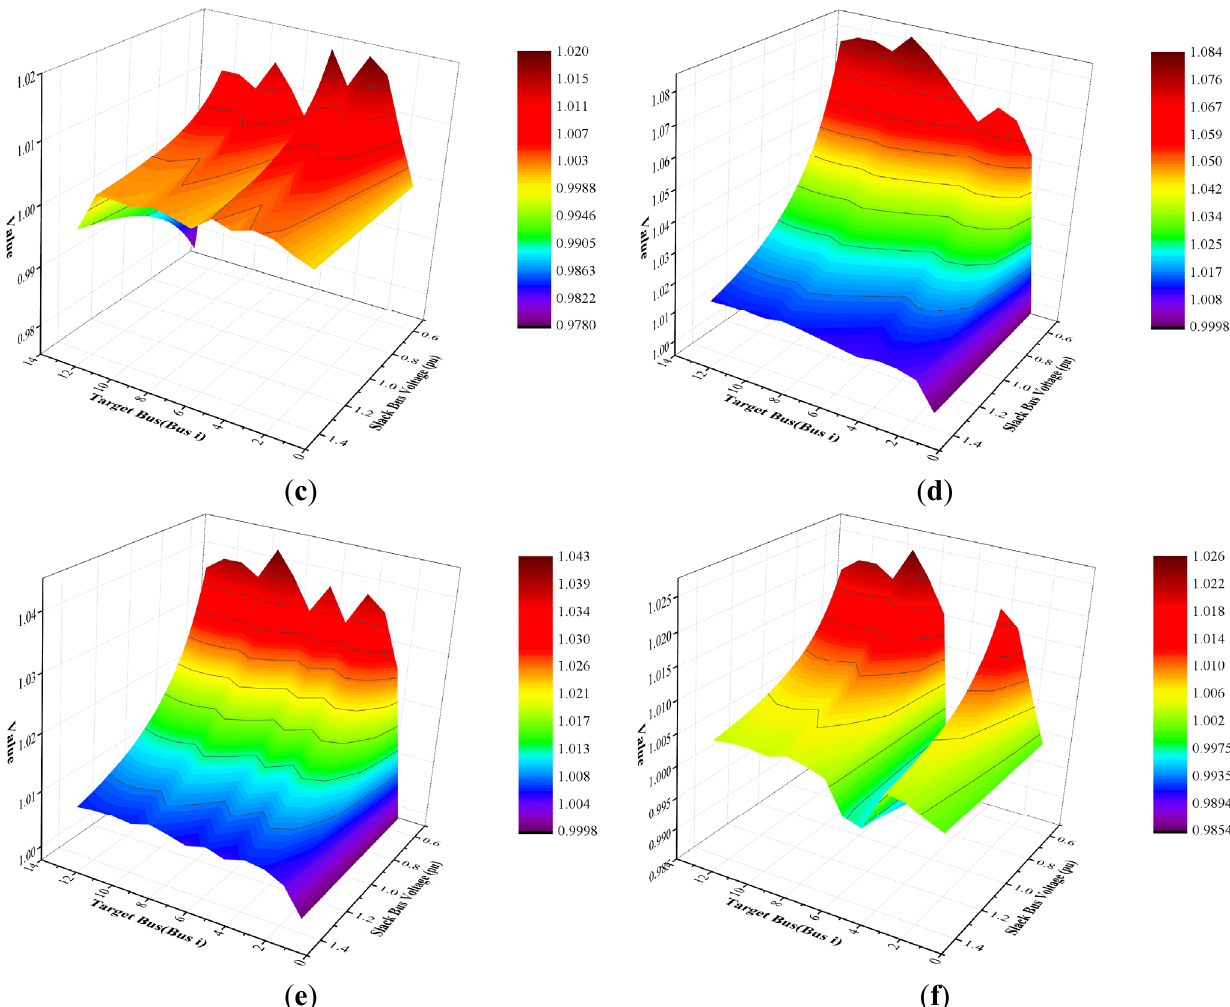
Figure 12. The results of the exact calculation of the voltage sensitivity in response to changes in the slack bus voltage. ( a ) The injected power at bus 13 is − 1 MW; ( b ) The injected power at bus 13 is 0 MW; ( c ) The injected power at bus 13 is 1 MW; ( d ) The injected power at bus 7 is − 1 MW; ( e ) The injected power at bus 7 is 0 MW; ( f ) The injected power at bus 7 is 1